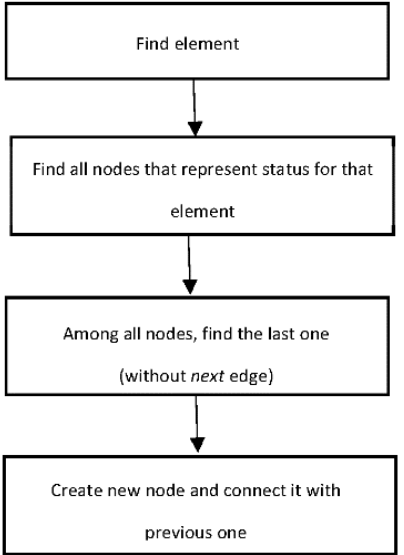
Figure 4. BDA for adding a new value (1 st approach).